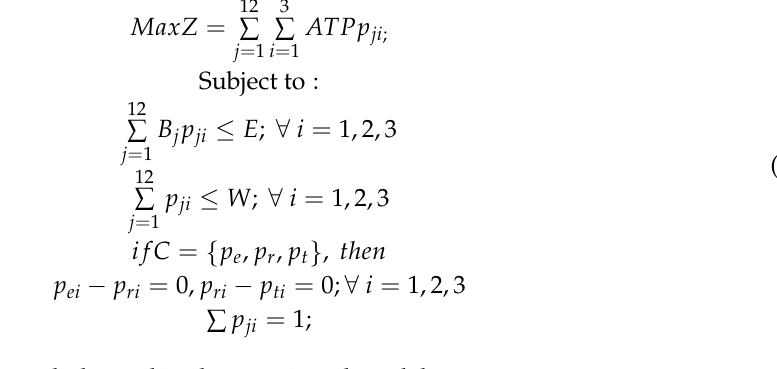
Table 1 introduces the symbols used in the mentioned model. Table 1.